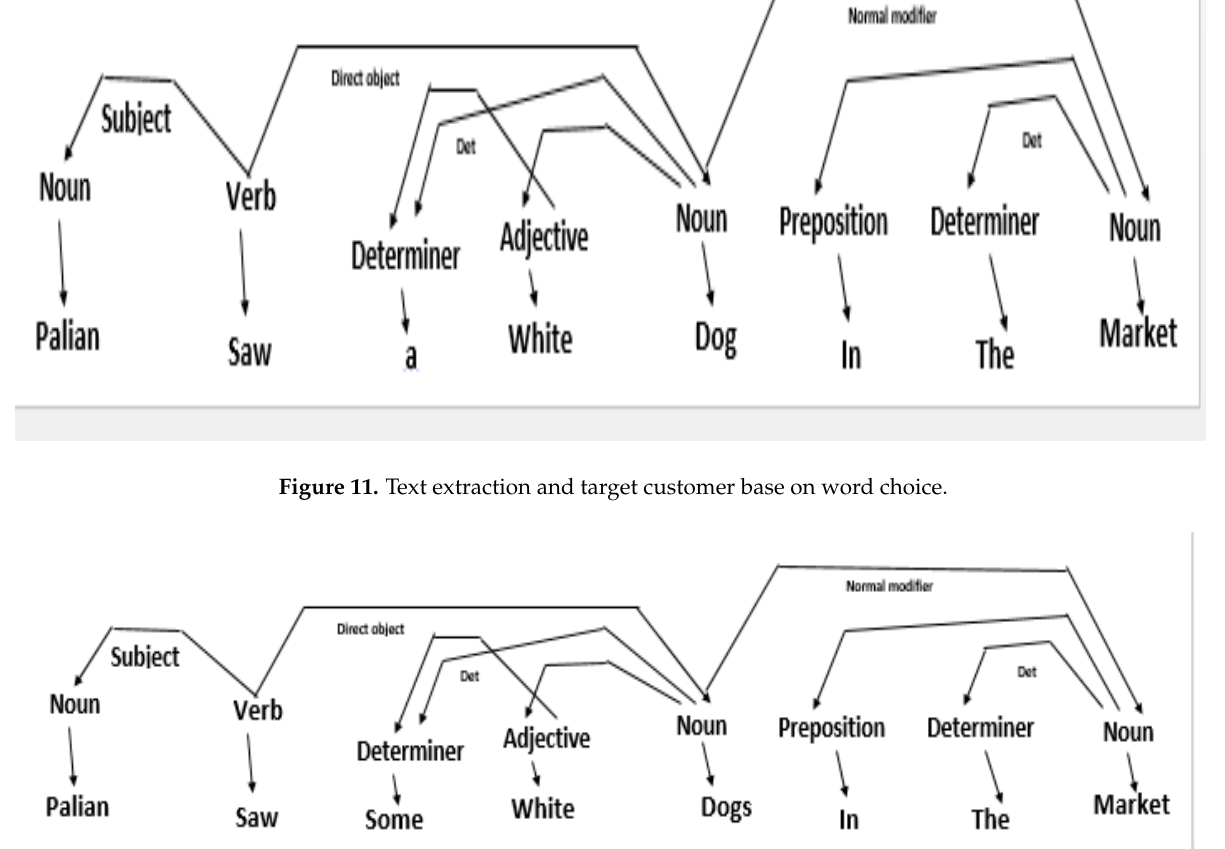
Figure 12. Text extraction and target adverts based on the audience’s choice of words.